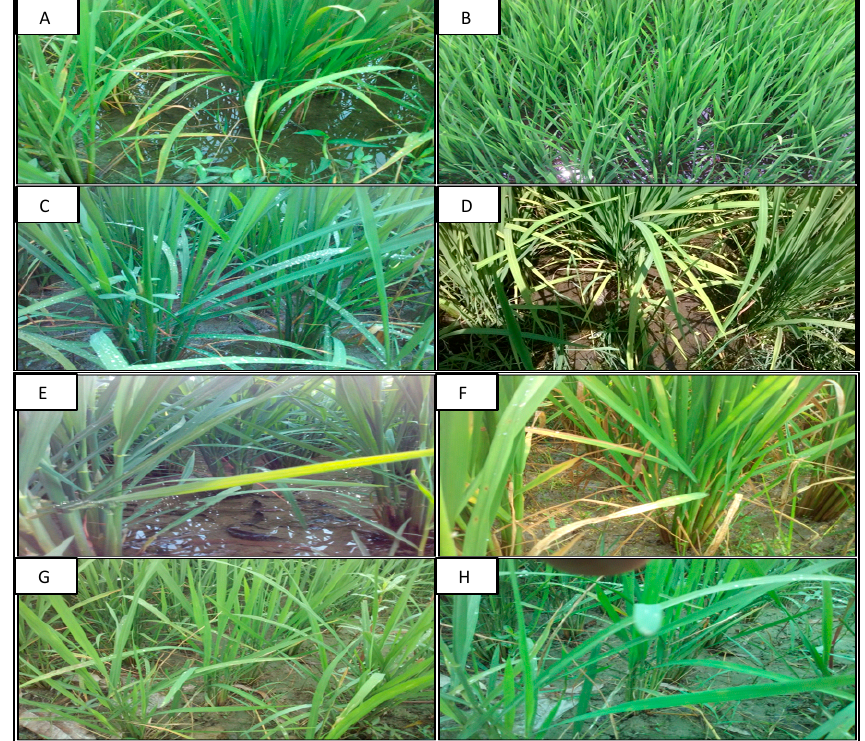
Figure 8. Variation of soil moisture conditions in lowTVDI area. Completely saturated with stagnant water ( A , B ), wet ( C ), and moist ground conditions ( D ). Irrigated fields with different levels of soil moisture deficit ( E – H ).